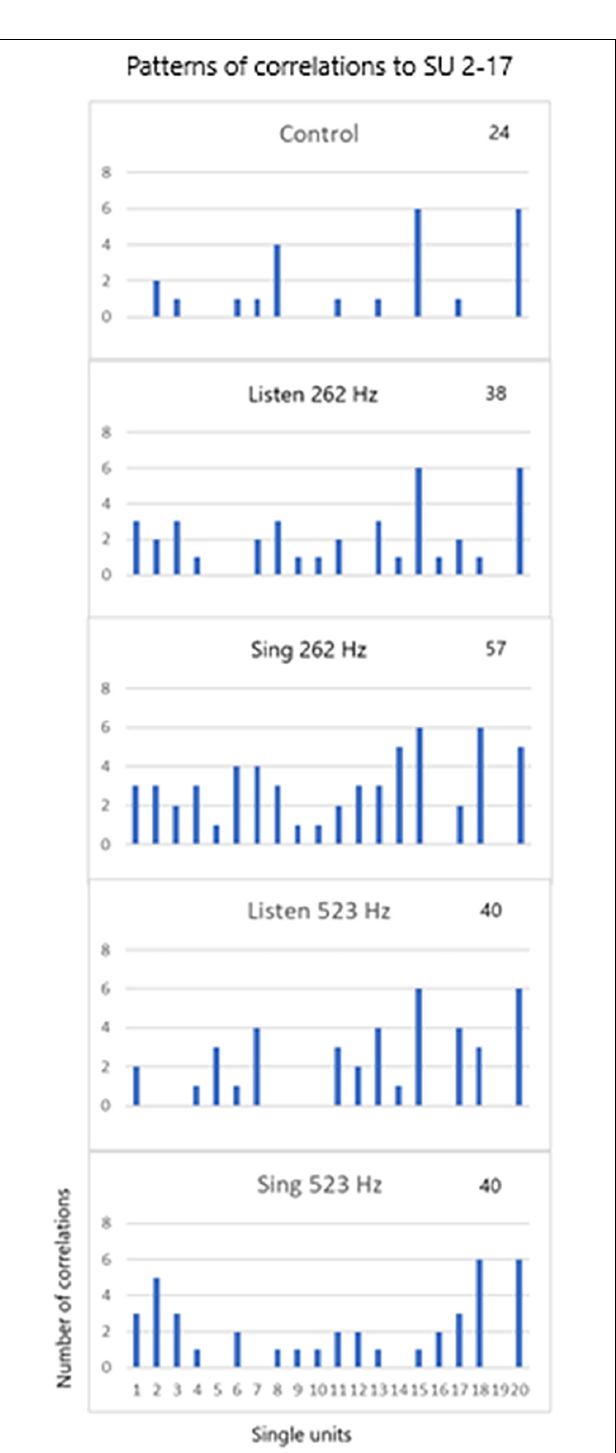
FIGURE 9 | SU 2-17 (SU #19 above) was used to cross correlate (XCorr) with the 19 other units during control periods of resting, periods of listening to the tones (262 and 523 Hz) and silent singing of the tones over six trials. The patterns of XCorrs is different between the different tasks: the pattern identifies the task. The total number of XCorrs (excitatory or inhibitory) is given as a number on each plot. Illustration of the patterns is demonstrated in the power point slide in Supplementary Material